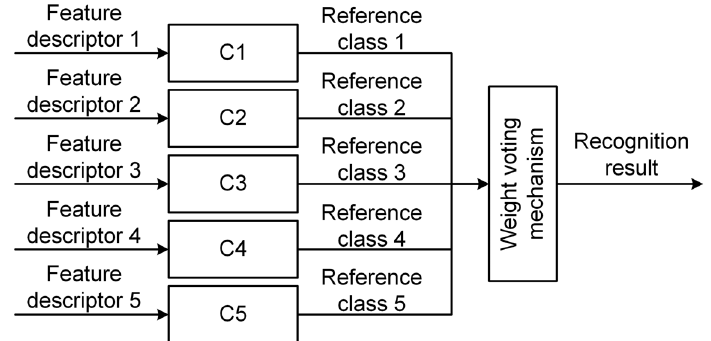
Figure 8. Construction of the weighted voting classification strategy, where C i indicates the i th classifier.